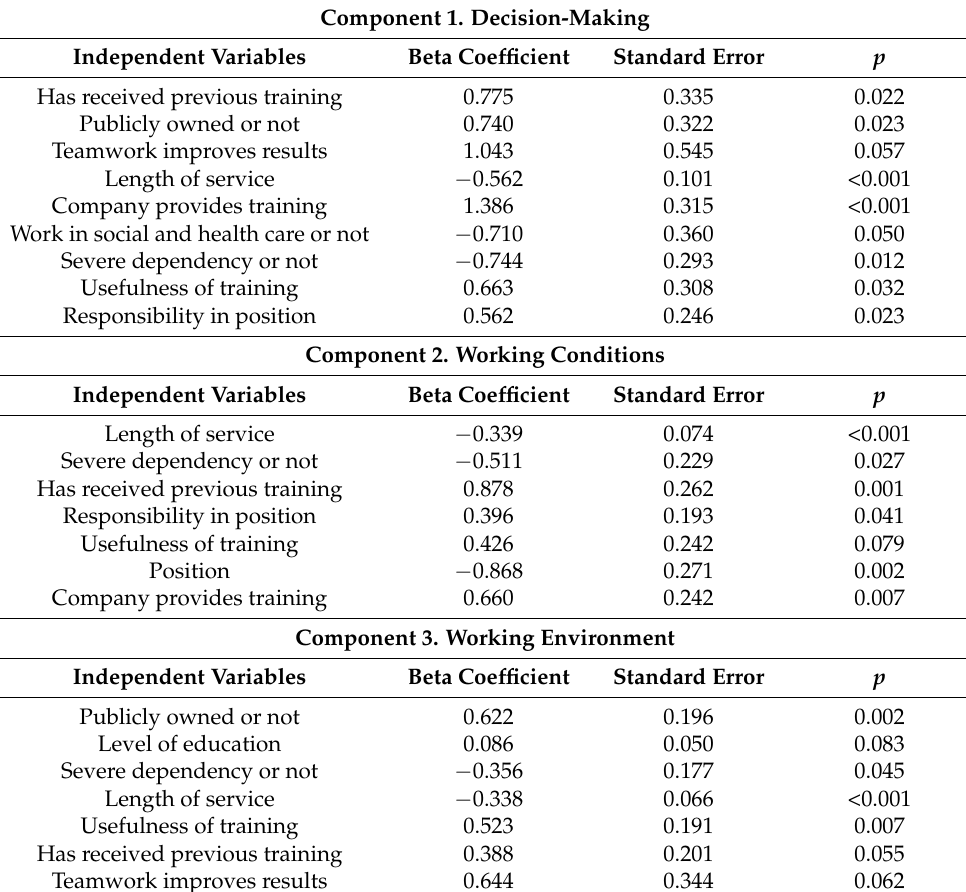
Table 4. Multivariate regression analysis of the components